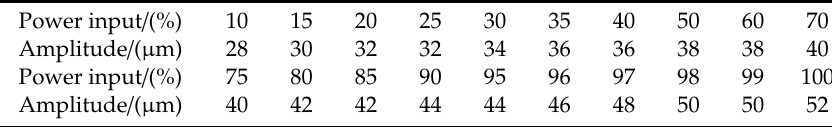
Table 3. Ultrasonic amplitudes corresponding to di ff erent power inputs.